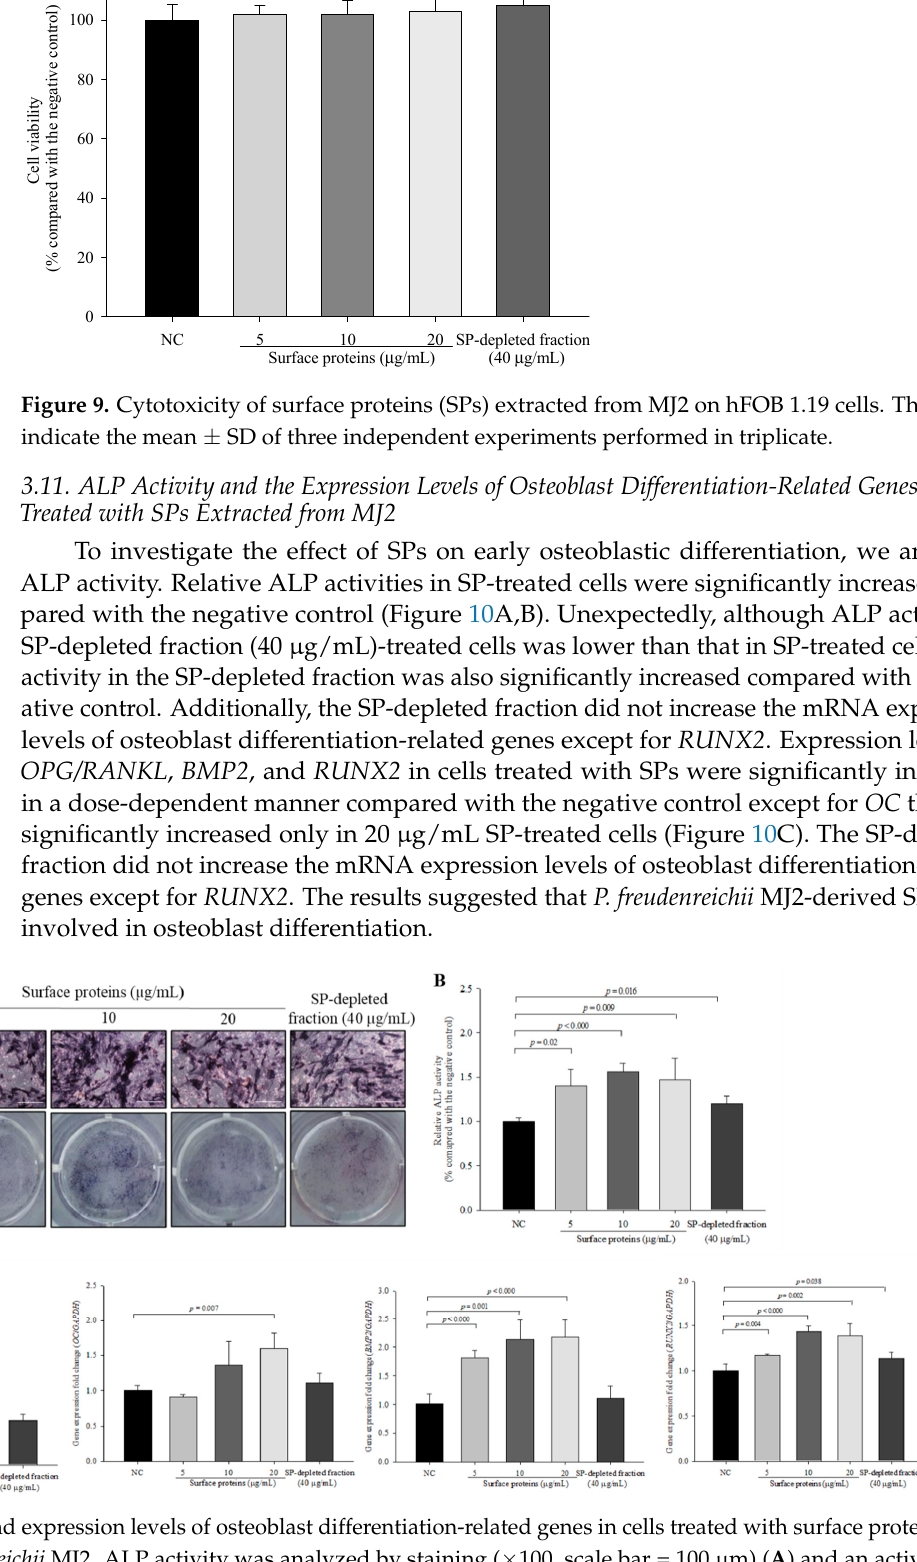
16 of 22 Figure 8. Effect of MJ2 and L. plantarum on the OPG/RANKL ratio and expression of osteoblast differentiation-related genes and proteins. The gene expression levels of OPG/RANKL ( A ) and expression levels of the proteins were measured by Western blotting ( B ) and quantified ( C ). Each value indicates the mean ± SEM of three independent experiments per- formed in triplicate. * p < 0.05, ** p < 0.01, and *** p < 0.001 compared with the OVX group. 3.10. Viability of Cells Treated with Surface Proteins (SP) Extracted from MJ2